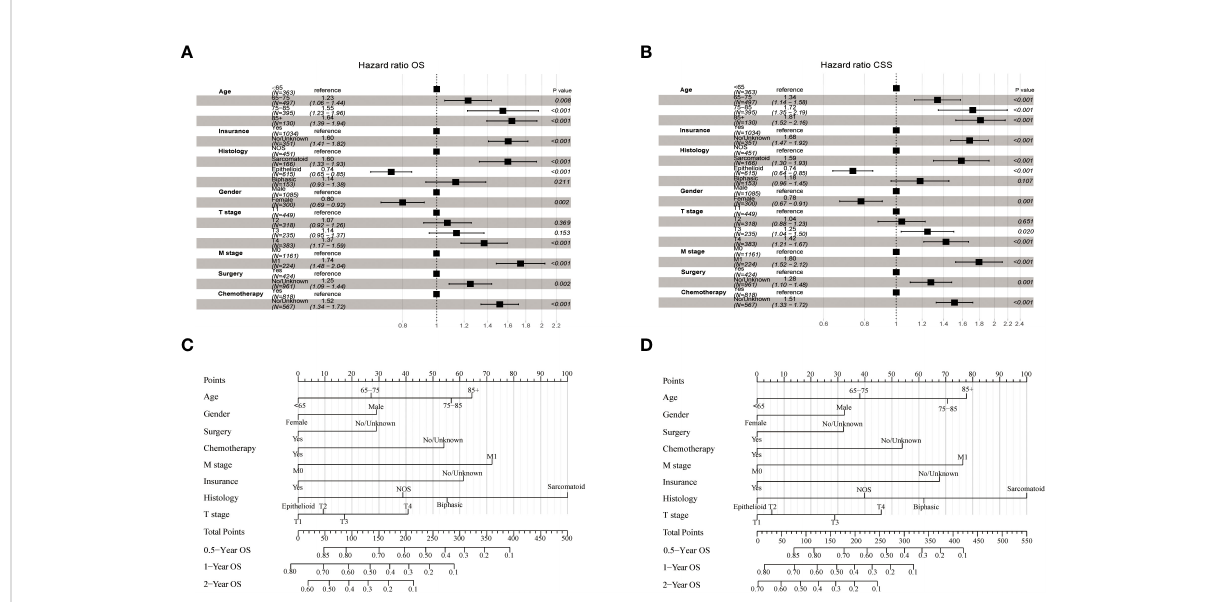
FIGURE 3 Forest plot demonstrating the LASSO-Cox regression model for OS (A) and CSS (B) in the training cohort and the Nomogram for predicting 0.5-, 1- and 2-year OS (C) and CSS (D) .